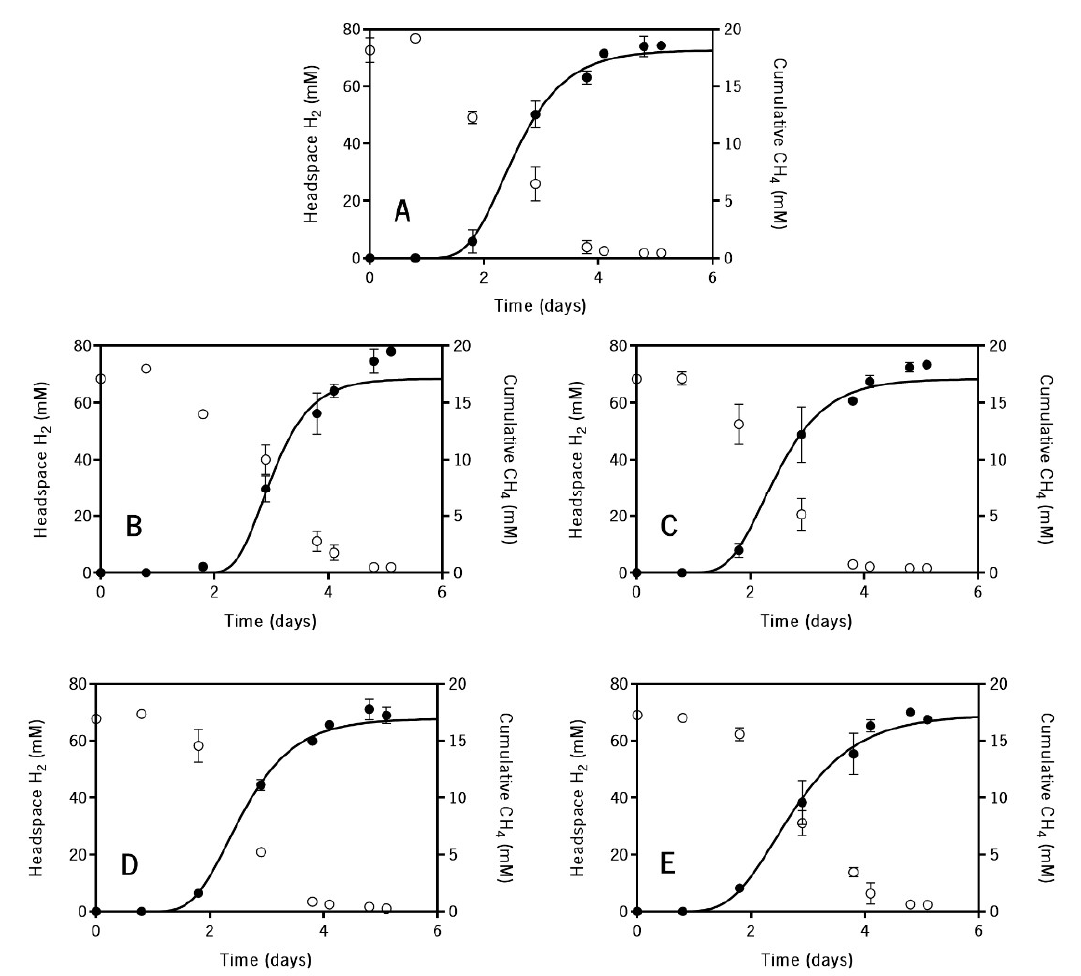
Figure 3. Effects of increasing hexadecane concentrations on H 2 consumption ( ○ ) and cumulative CH 4 production (●) by M. hungatei : ( A )–0 mM, ( B )–1 mM, ( C )–5 mM, ( D )–15 mM, and ( E )–30 mM. The black line represents the fitting of the cumulative methane production data by the modified Gompertz equation. Table 1. Methane production parameters calculated by fitting the experimental data from the toxicity assays with M. formicicum and M. hungatei to the modified Gompertz model. λ , lag-phase; P, maximum CH 4 production; Rm, maximum CH 4 production rate; and R 2 , coefficient of determination. Methanogen